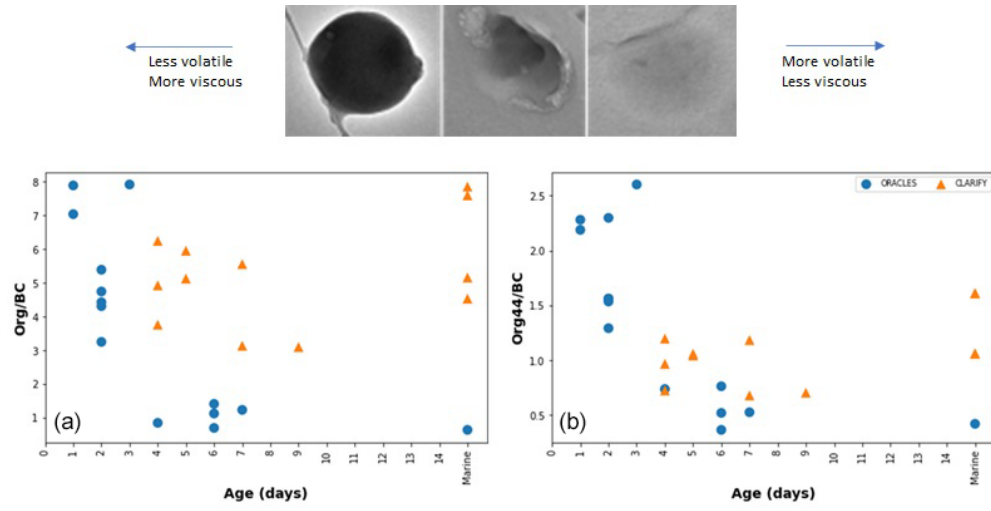
Figure 3. Example of organic aerosol of different viscosity and volatility, (a) showing more round and viscous particles for ORACLES (on the left) and more volatile particles for CLARIFY (middle and right top panels). (b) Org / BC and (c) Org44 / BC ratios are shown with time from fire